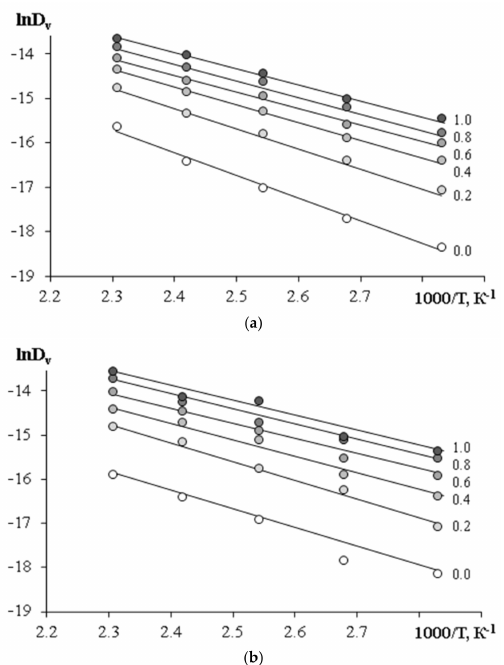
Figure 13. The temperature dependences of lnD v for PCL–DGEBA mixtures: ( a ) M n = 45 × 10 3 ; ( b ) M n = 80 × 10 3 . PCL concentrations are indicated near the straight